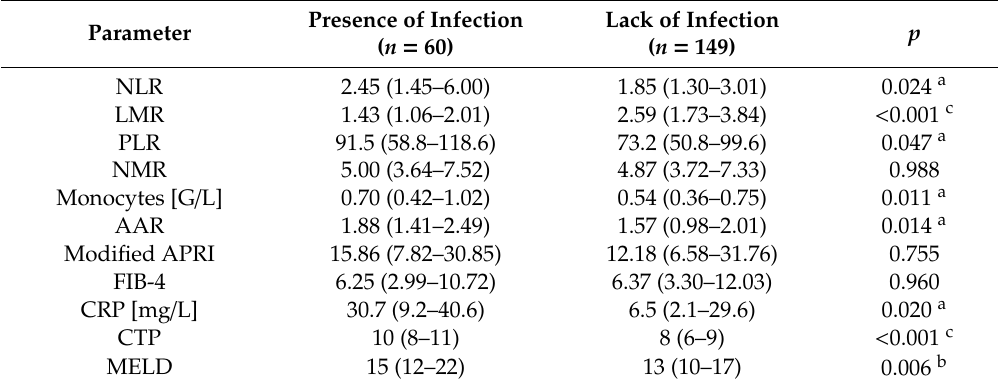
Table 3. Median and lower-upper quartile range of laboratory and clinical results in two groups of patients: with and without